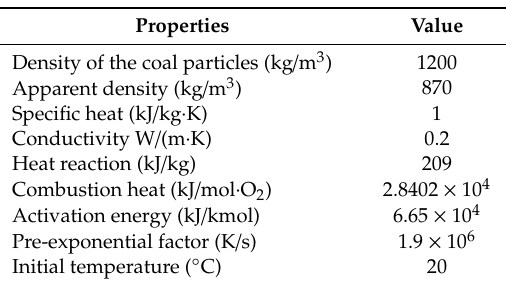
Table 3. Simulation conditions.